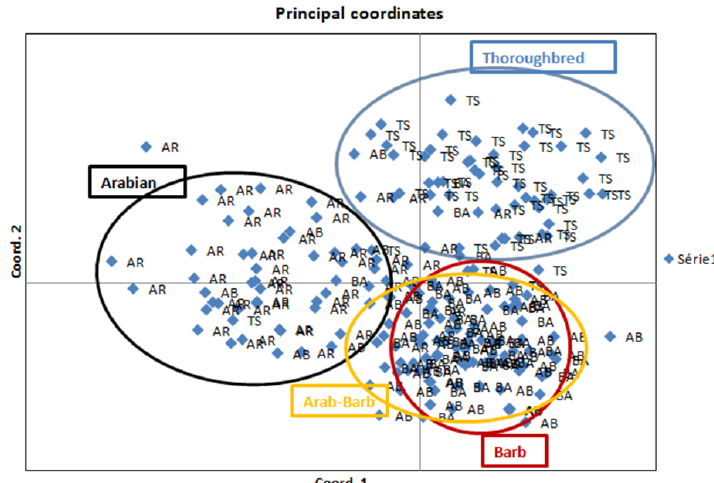
Figure 2. Principal component analysis for the Tunisian horse breeds.